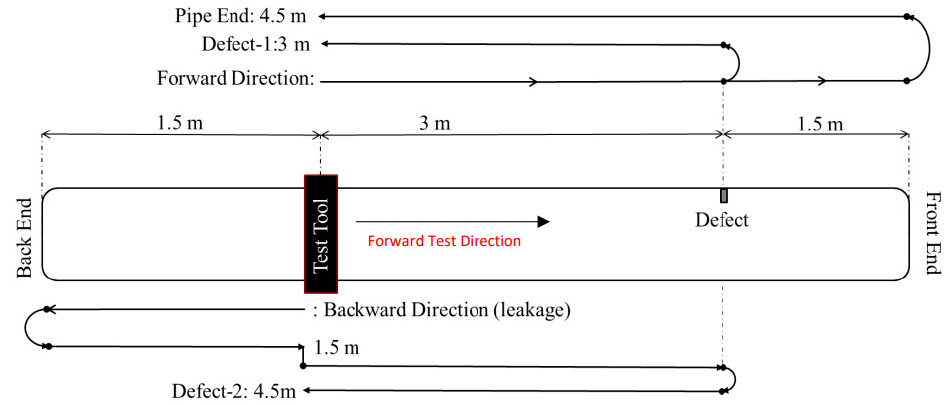
Figure 15. Torsional mode reception route for laboratory trials.